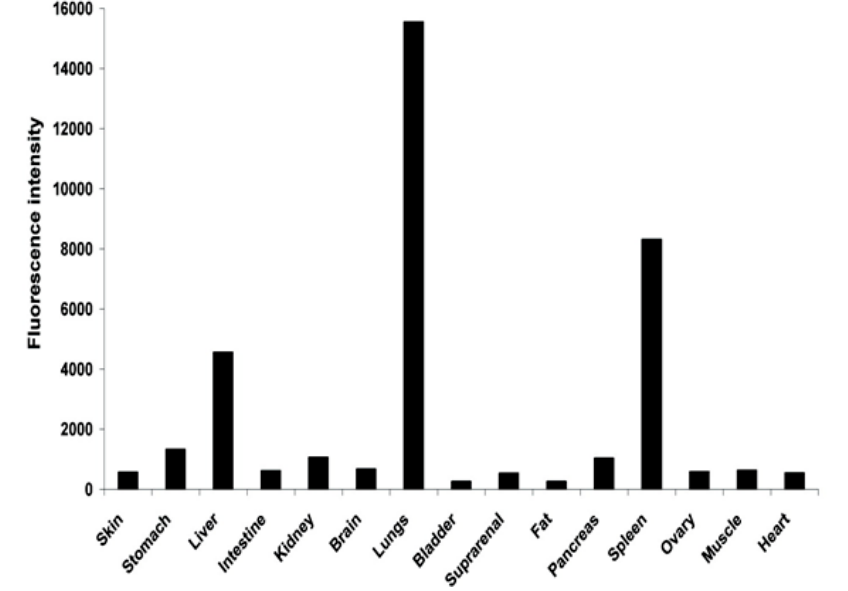
Figure 11. Biodistribution of the CIS/ZnS NCs 24 h after tail vein administration of a mouse [49].